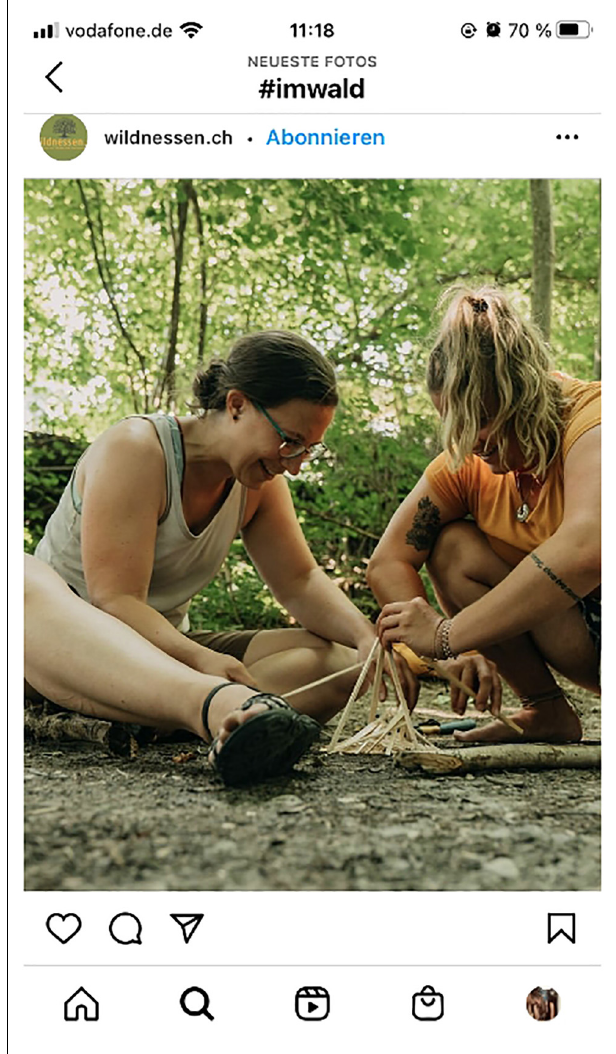
FIGURE 7 | Forests as places for building activities (source: